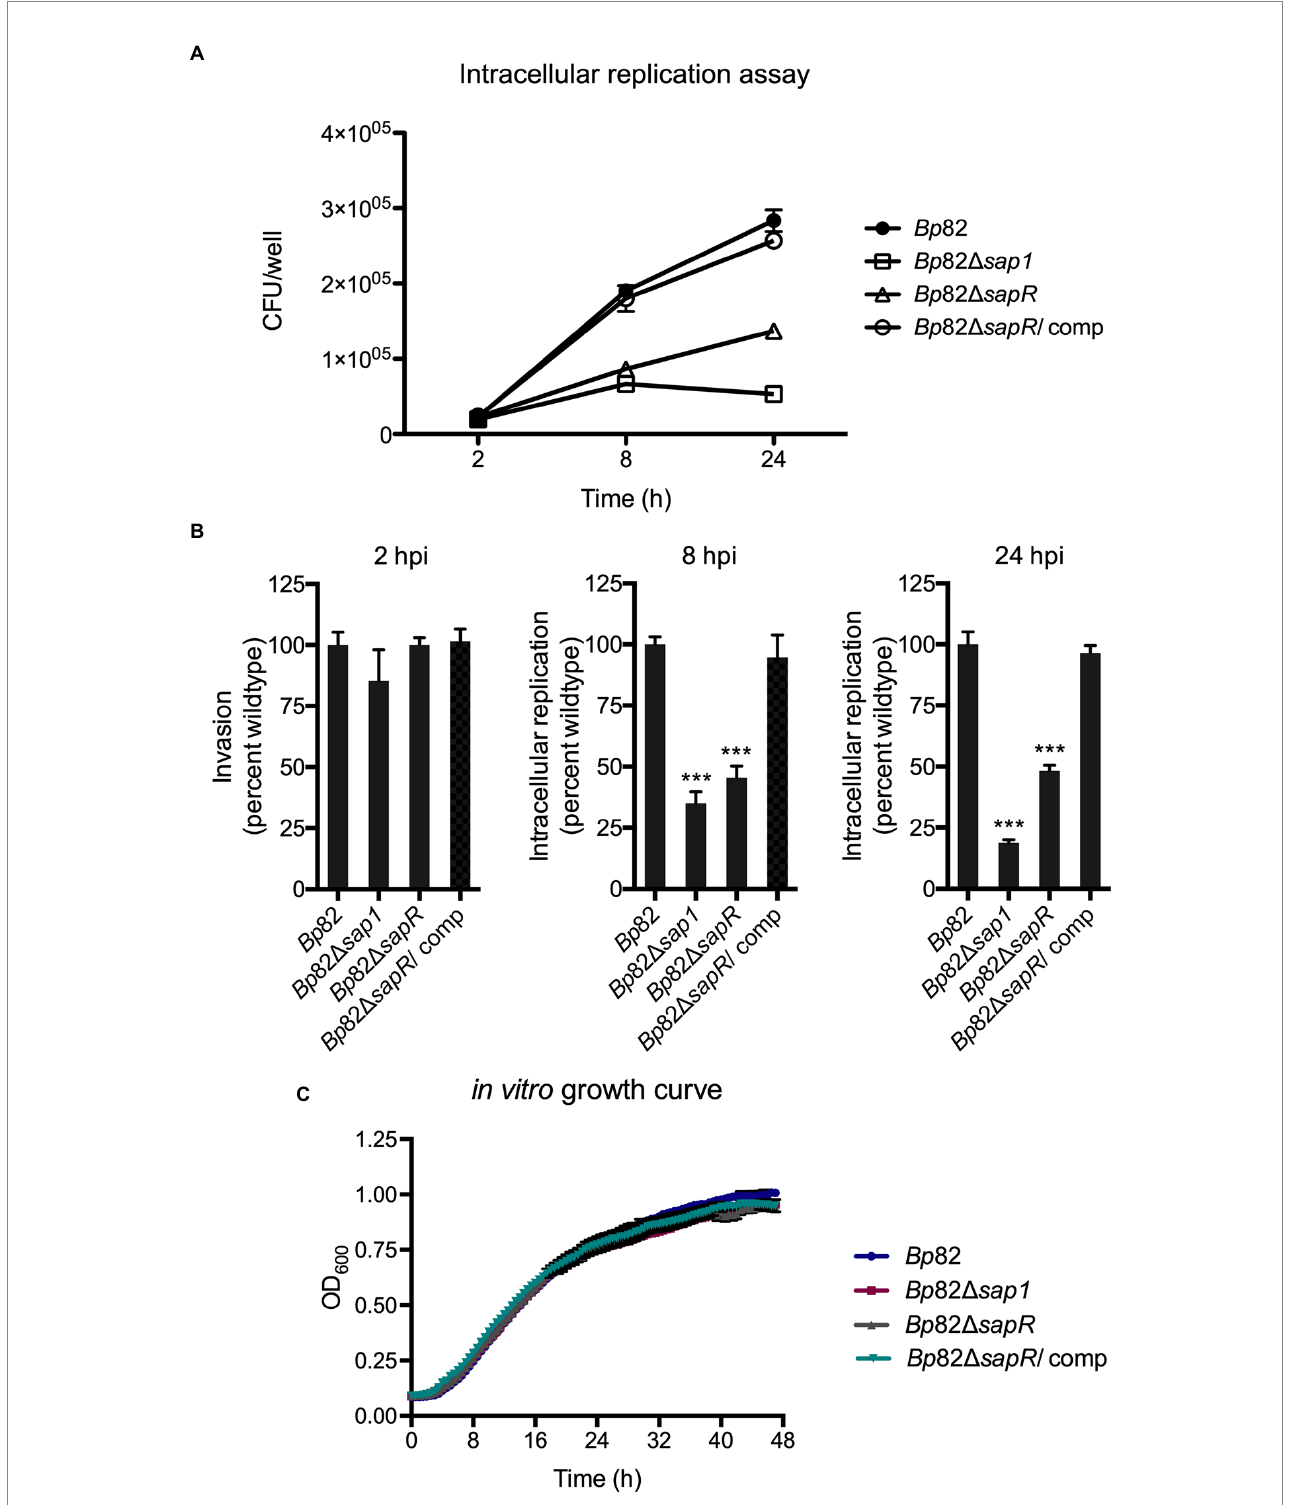
FIGURE 4 The Δ sapR mutant is highly defective during intracellular replication. (A) Bp82 , Δ sap1 , Δ sapR , and Δ sapR /comp strains were analyzed for their ability to replicate in RAW264.7 murine macrophages at initial MOI of 10:1. CFU/well of each strain was numerated at 2, 8, and 24 h post infection (hpi). (B) The percent wildtype were calculated and the averages of triplicates were presented with error bars representing SEM. The Δ sap1 and Δ sapR mutants displayed significant defect in replication at 8 and 24 hpi compared to the Bp82 strain. Data in bar graphs represent means ± s.e.m. and analyzed via unpaired t -test. *** p < 0.001. (C) In vitro growth analysis of Bp 82, Δ sap1 , Δ sapR , and Δ sapR /comp in LB + Ade liquid media. Mutants show no in vitro growth defects compared to wildtype strain while growing under the same